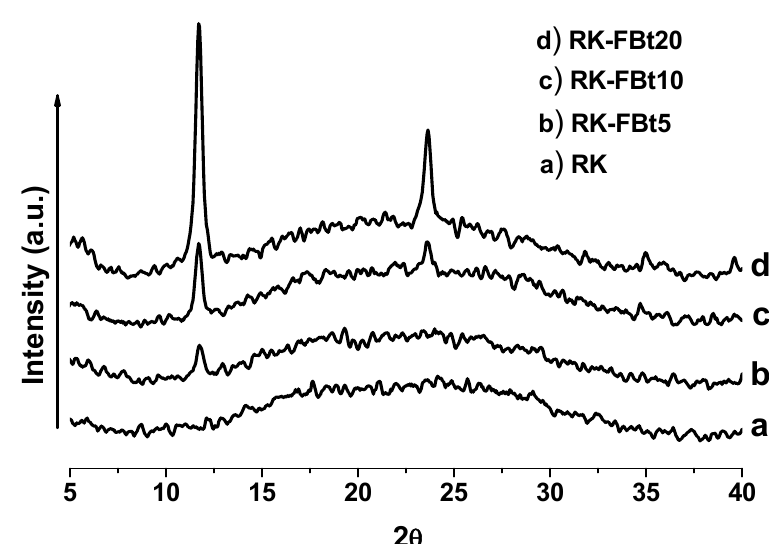
Figure 2. XRD patterns of the neat resin RK ( a ) and the hybrid composites samples at different LDH-F and Bt content, RK-FBt5 ( b ), RK-FBt10 ( c ), and RK-FBt20 ( d ).